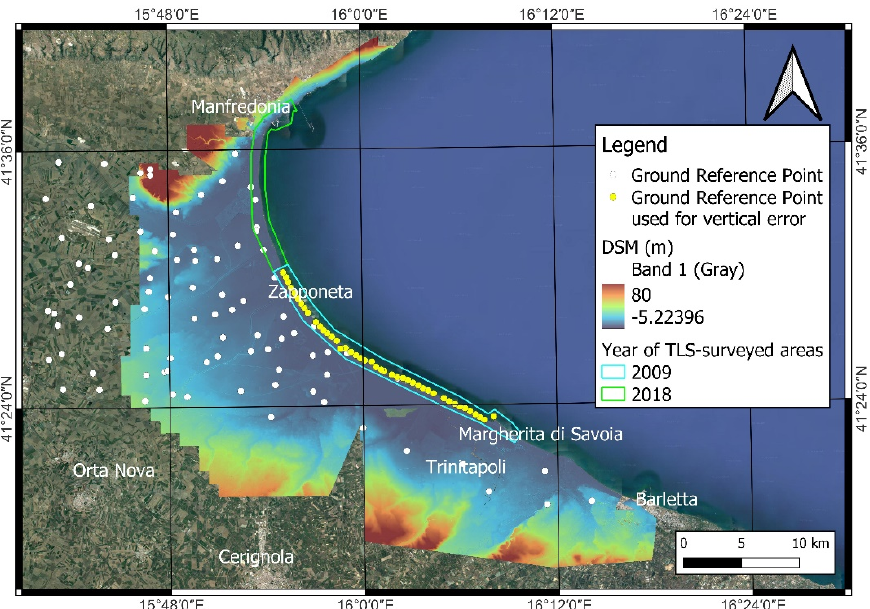
Figure 3. Digital Surface Model (DSM) obtained for the coastal area. The ALS data were acquired for the inland areas [52] while TLS surveys were performed for the coastal area (light blue and green polygons). The Ground Reference Points (GRPs, white points) were obtained through GPS static survey and Total Station leveling; the GRPs reported in yellow were used for the vertical error assessment of DSM. Background map was obtained from Google Satellite.